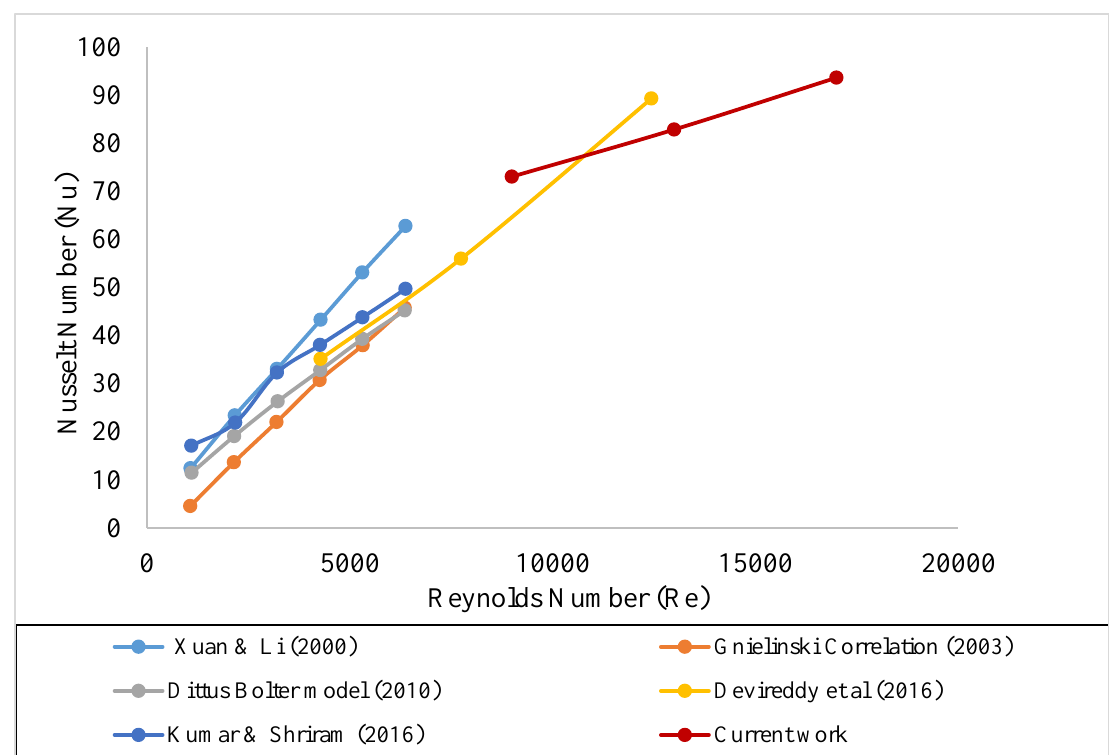
Figure 20. Interaction of Nusselt number and Reynolds number. Figure 19. Interaction of nozzle-plate distance and nozzle-nozzle spacing levels at optimum levels of other